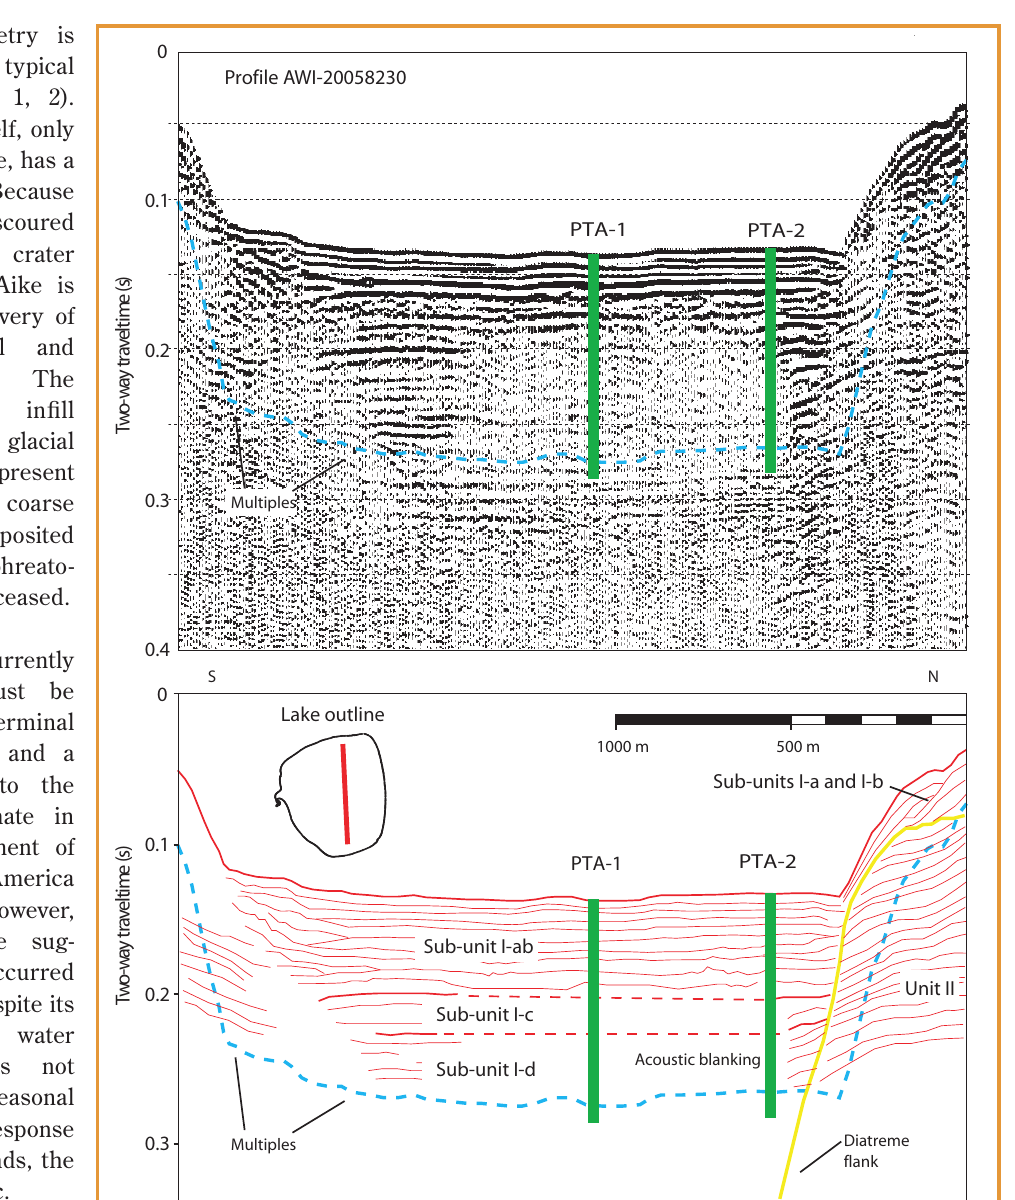
Figure 2. S-N multi-channel seismic reflection profile from Laguna Potrok Aike with uninterpreted seismic section (top) and interpreted line drawing (bottom). Drill sites PTA-1 and PTA-2 are marked. Inset (top left) shows outline of Laguna Potrok Aike with multi-channel seismic line (red) from Fig.